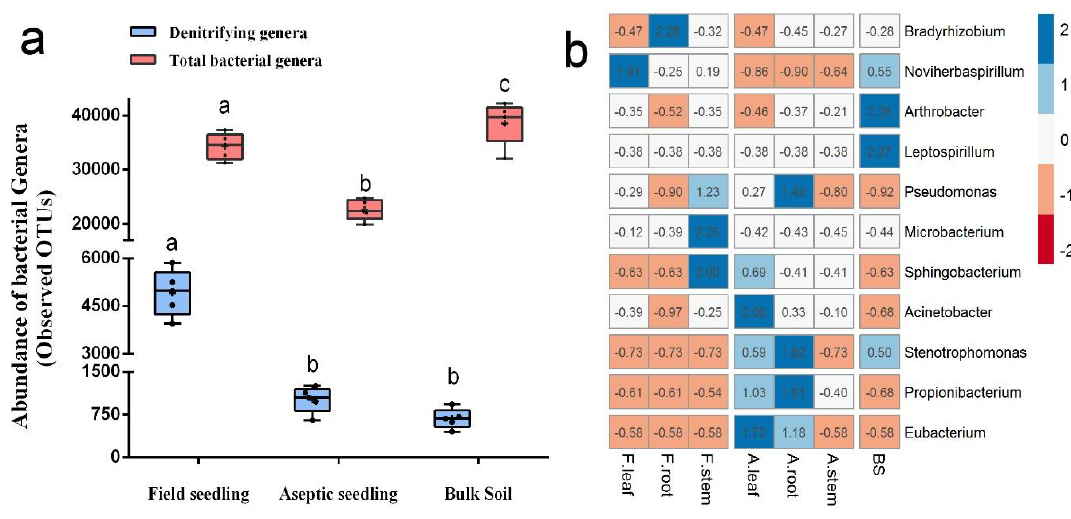
Figure 5. ( a ) Bar plot showing the abundance of total aerobic denitrification related genera and total bacterial genera from a holistic perspective. t -test analysis indicates high significant differences obtained from the abundance of denitrifying genera in field seedlings ( p < 0.05). The same letter on the bars indicate no significant differences between means at ( p < 0.1). ( b ). Heat map showing the distribution of denitrification related genera in differently cultured soybean organs and bulk soil. The colour of the squares on the left indicates the relative abundance of the genera in each group. Normalized relative abundance (from 2 to −2) was marked on the colour block.